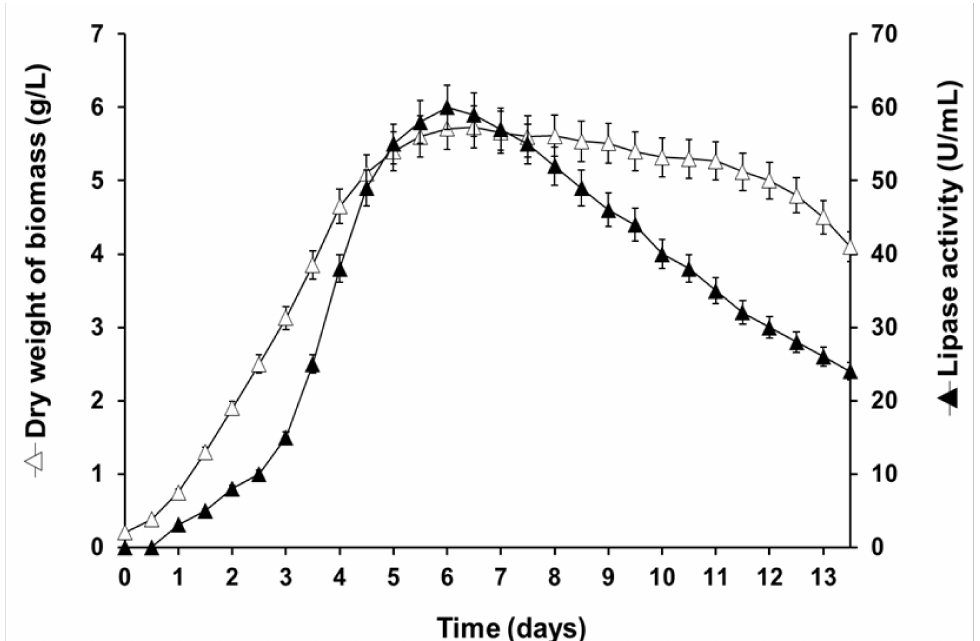
Figure 2. Time course of the production of PCrL from strain P22 after cultivation in liquid medium. The cultures were carried out in 250 mL Erlenmeyer flasks as described in Section 4 (Section 4.6). Lipase activity was measured using TC8 as the substrate. Each data point (mean ± SD) is the result of triplicate